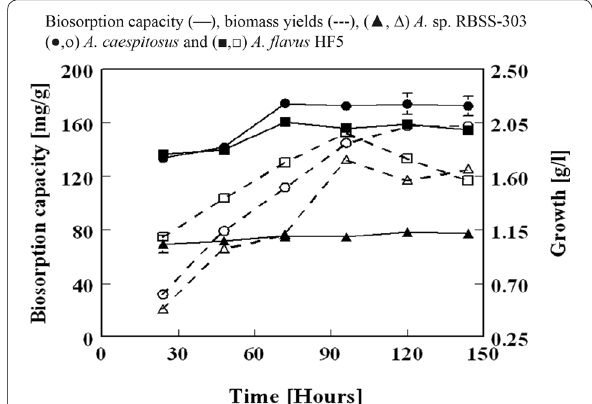
Fig. 1 Effect of A. sp. RBSS-303, A. caespitosus and A. flavus HF5 cul- ture age on Pb(II) uptake capacities (W 0.05 g, pH 4.5, tempera- = = ture 28 2 °C, C i 100 mL, V 100 mL, agitation rate 180 rpm) = ± = = =